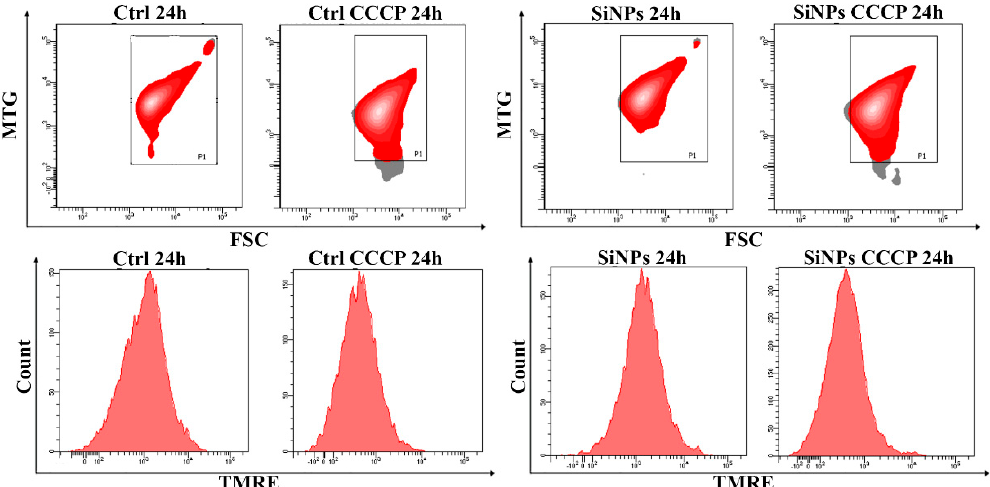
Figure 2. SiNPs uptake study of U937 isolated mitochondria and mitochondrial mass investigation. Sequence of analysis by flow cytometry of MTG staining of isolated mitochondria from controls and NP − incubated cells, respectively, and treated by CCCP at 24 h. Above: contour plots FSC vs. MTG (FITC); below: histograms of TMRE staining.